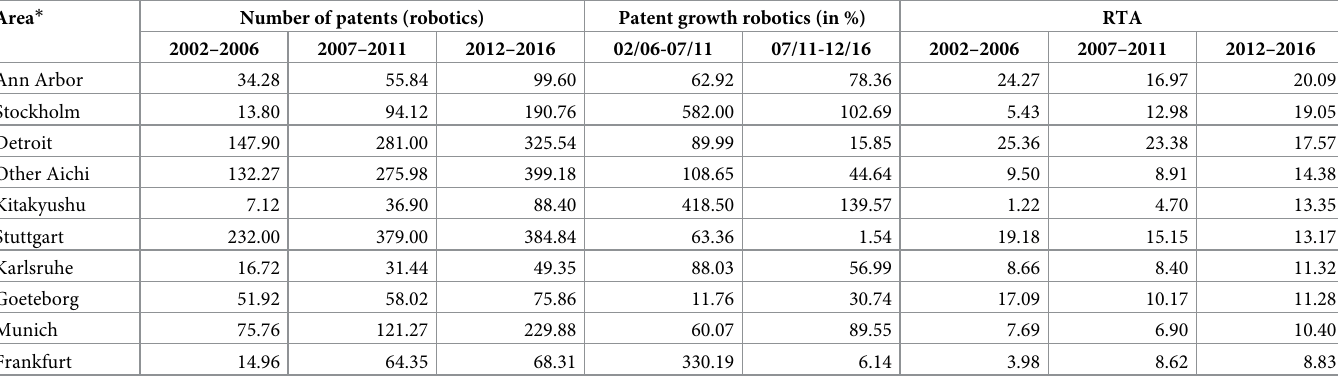
Table 1. R&D hotspots in robotics (top ten) and their relative specialisation (RTA). Area